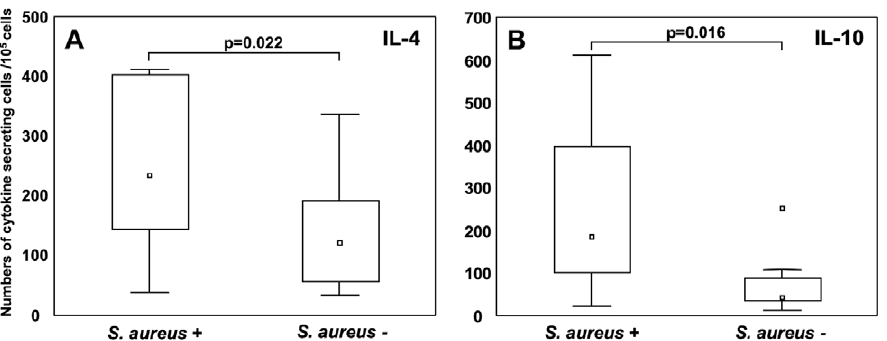
Figure 2. S.aureus colonization at 2 weeks of age in relation to cytokine secreting cells, after invitro PHA stimulation at age two. Infants with (n=19) or without (n=8) S. aureus at 2 weeks of age in relation to (A) IL-4 2 and (B) IL-10 producing cells after PHA stimulation. Boxes cover 25 th to 75 th percentile and the central square being the median value. Whiskers extend to non-outlier maximum and minimum, squares and stars represents outliers and extremes, respectively. doi:10.1371/journal.pone.0049315.g002 PLOS ONE |